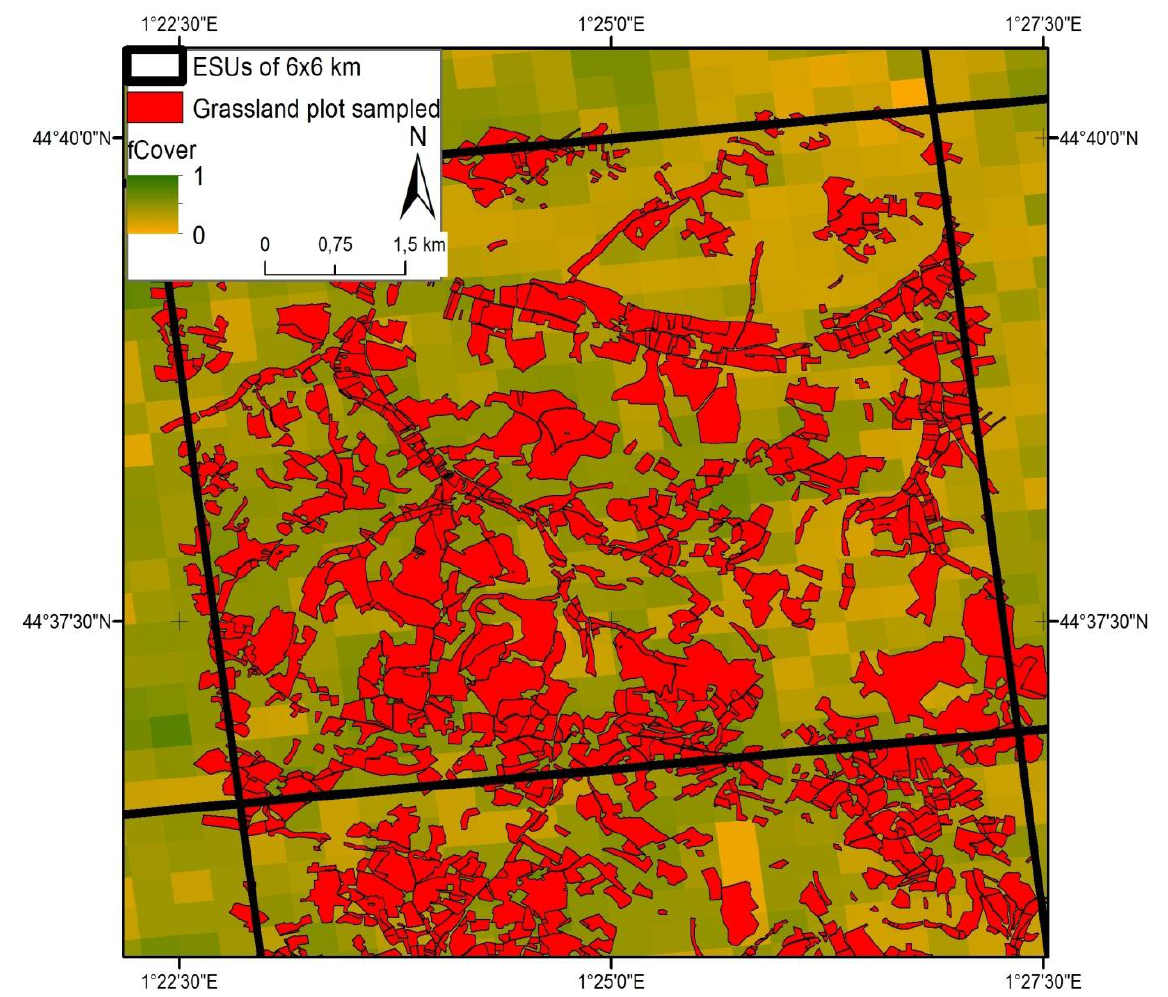
Figure 7. Grassland plots extracted from the Common Agricultural Policy database and used for indirect comparison. The background image is a 10-day MODIS fCover product for the period 11 February 2012 to 20 February 2012 at a spatial resolution of 300